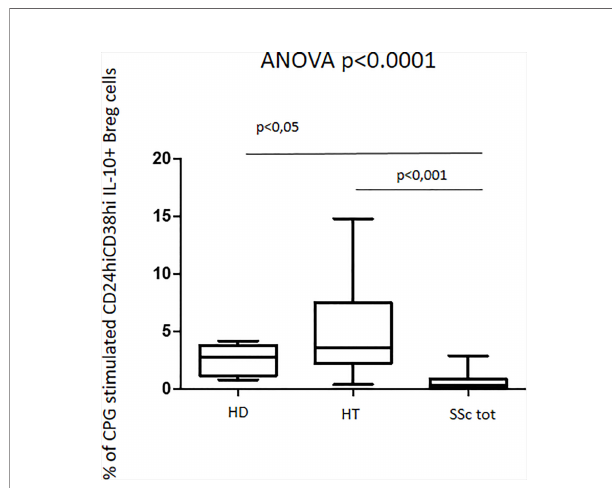
FIGURE 6 | Percentage of CpG-stimulated CD24hiCD38hi IL10 + Breg cells in patients with SSc as compared with both HT patients and healthy donors (HD). Kruskal – Wallis followed by Dunn posttest was used for multiple